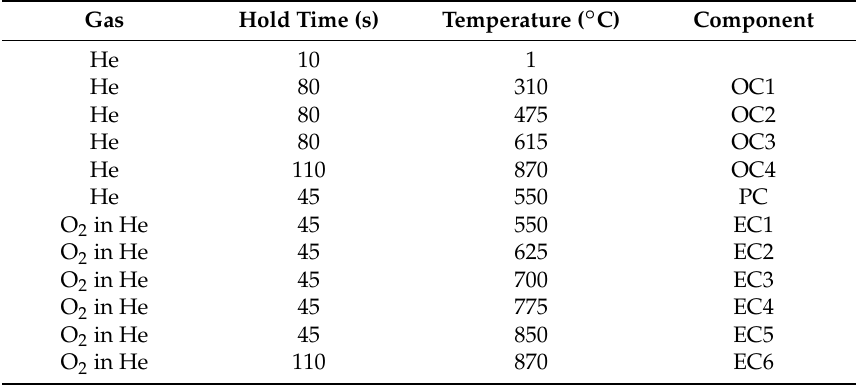
Table 1. Experimental parameters for the thermal/optical analytical protocol.